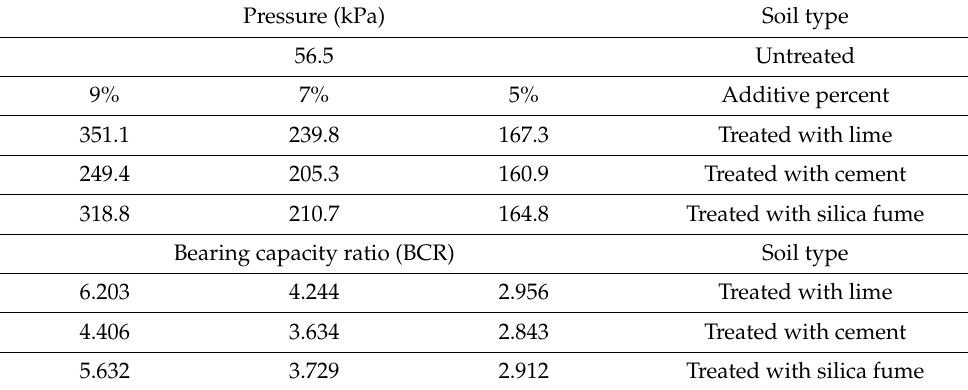
Table 6. Applied pressure at failure and bearing capacity ratio.